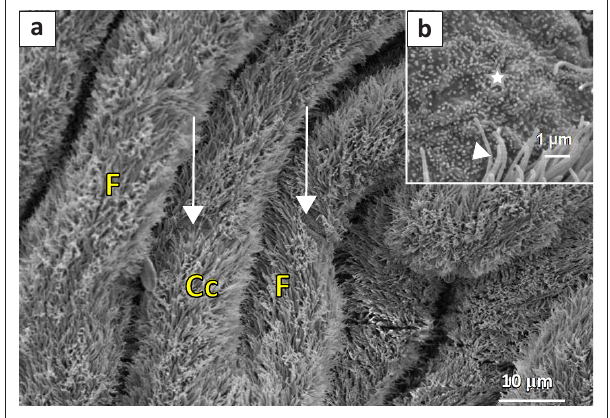
(a) The mucosal surface is thrown into folds (F); Cc, ciliated; Arrows, non-ciliated cells. (b) Note the presence of numerous microvilli lining the apical surface of non-ciliated cells (asterisk); Arrowhead, cilia. FIGURE 5: Scanning electron photomicrographs of the mucosal surface in the magnum of a control bird.